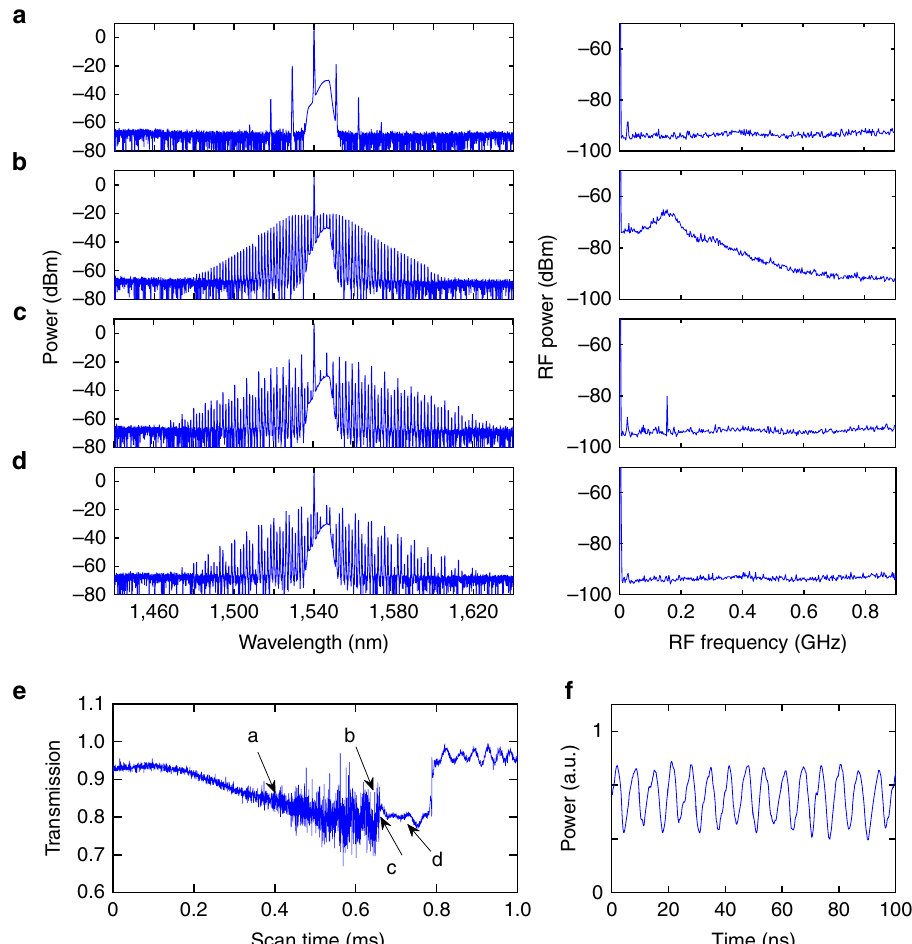
Figure 2 | Observation of breather solitons in Si 3 N 4 microresonators. ( a – d ) Optical and RF spectral evolutions where the state ( c ) shows breather solitons in Si 3 N 4 . ( e ) The pump power transmission as the laser frequency is scanned across the resonance. The scanning window corresponds to an absolute pump detuning range of 17GHz. The arrows correspond to the four regions ( a – d ). The transmission step is indicative of soliton formation. ( f ) The recorded time trace of the comb output power at the breather soliton state ( c